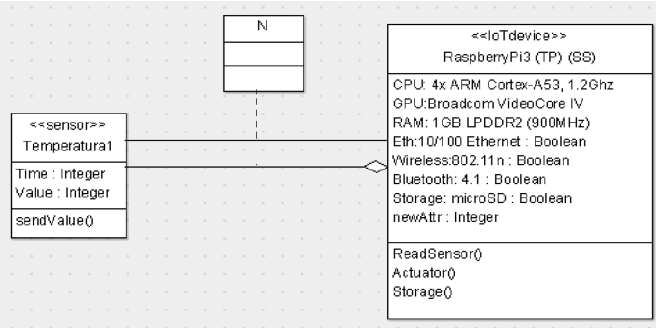
Figure 1. An example of a UML stereotype for an IoT device in a class diagram, taken from [[25], 2021, IEEE].